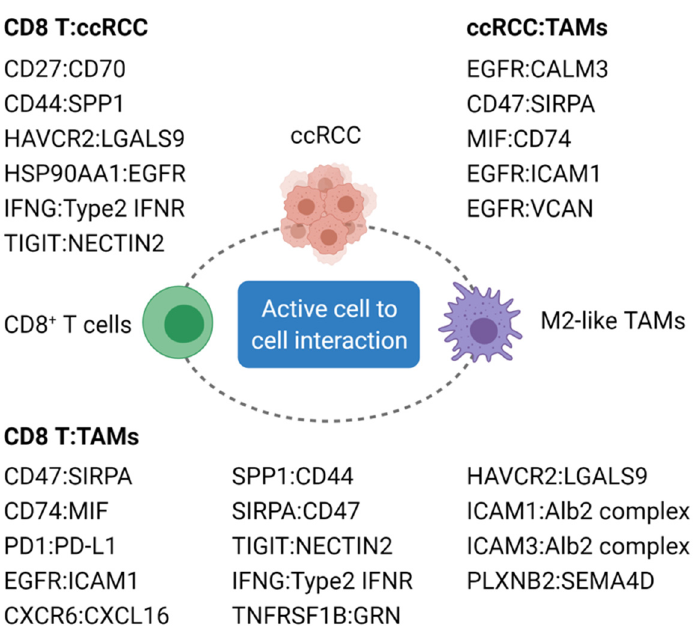
Figure 2. Ligand and receptor pairs potentially associated with ccRCC progression and resistance to ICI. A potential list of ligand and receptor pairs that are predicted by in silico analysis and commonly identified by published ccRCC scRNAseq studies are present. The cell to cell interaction via ligand and receptor pair has not been validated at the functional level. Abbreviation: ccRCC; clear cell renal cell carcinoma, TAMs; tumor-associated macrophages.